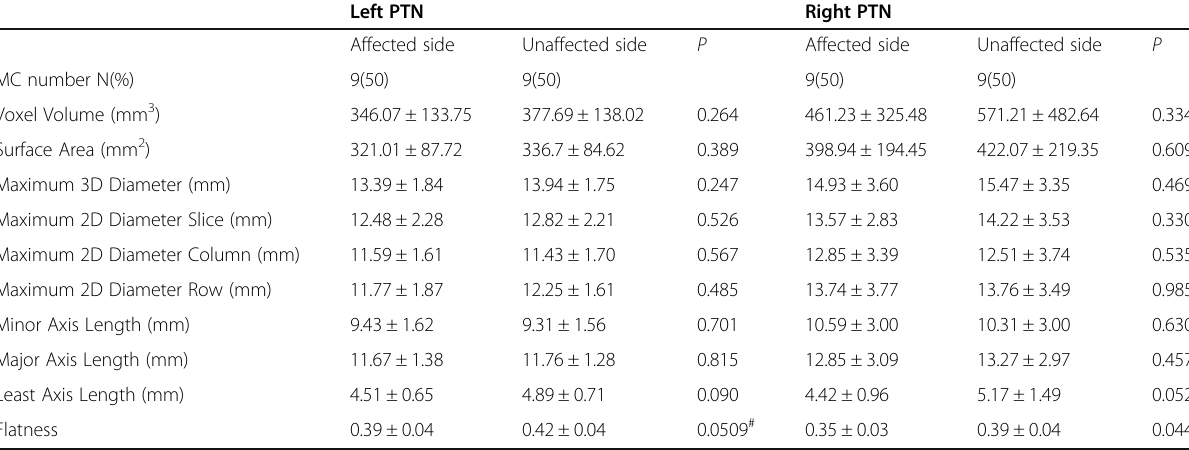
Table 4 Morphological analysis of MC in PTN group without bilateral NVC Left PTN Right PTN Affected side